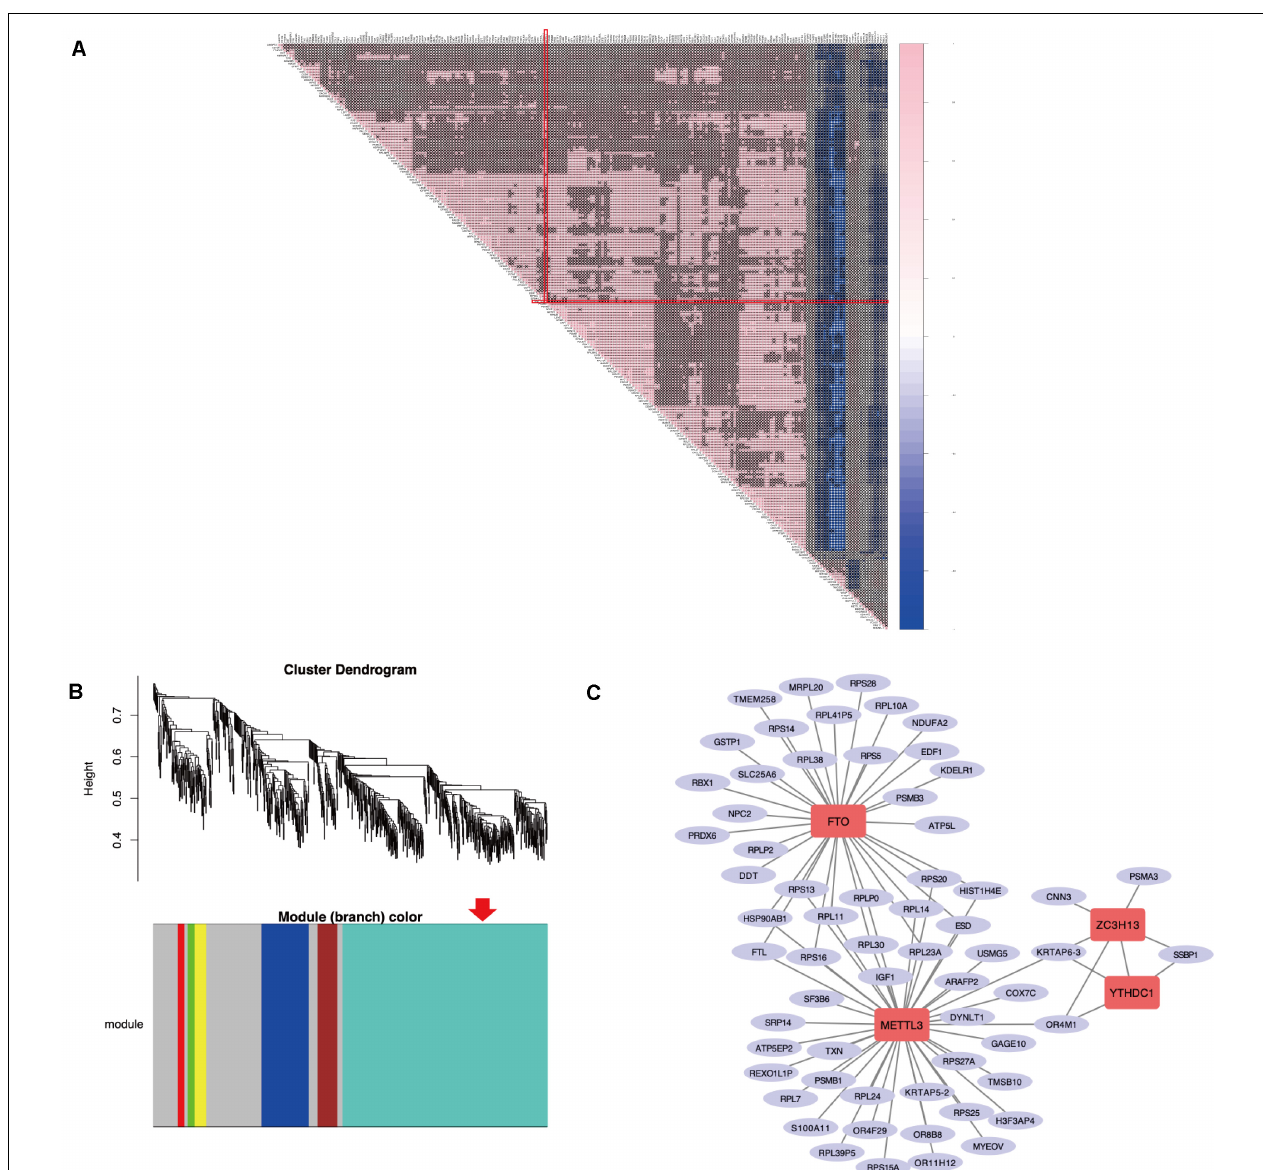
FIGURE 3 | The correlation analysis and WGCNA of DEGs in the eutopic endometrium. (A) The Spearman correlation analysis of the m 6 A modification regulators and the DEGs enriched in the GO terms that related to eutopic endometrium dysfunction of adenomyosis. “X” p > 0.001, Red line clarified that correlation between METTL3 and other DEGs. (B) WGCNA of DEGs in the eutopic endometrium of women with adenomyosis versus without. Red arrow revealed the module that the m 6 A RNA methylation regulators belong to. (C) The co-expressed genes of four differential expressed m 6 A RNA methylation regulators using WGCNA analysis (threshold =